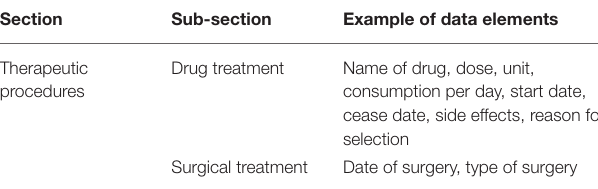
TABLE 2 | Some of administrative and clinical data elements of